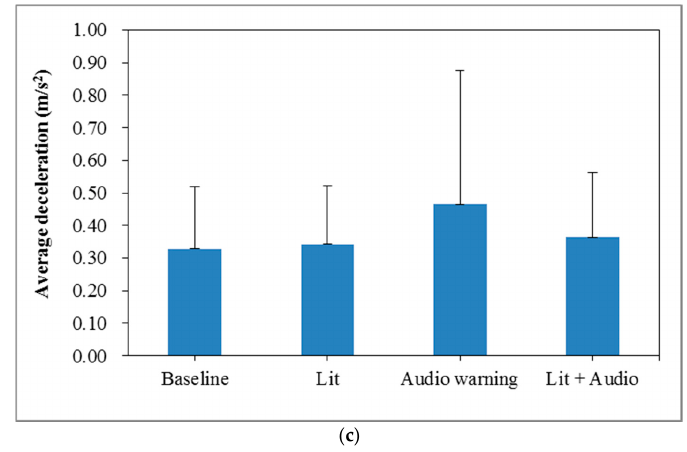
Figure 4. Maximum deceleration, corresponding location and average deceleration with significant factors. ( a ) Maximum deceleration with driving experience and gender; ( b ) location with scenario and driving experience; ( c ) average deceleration with scenario.